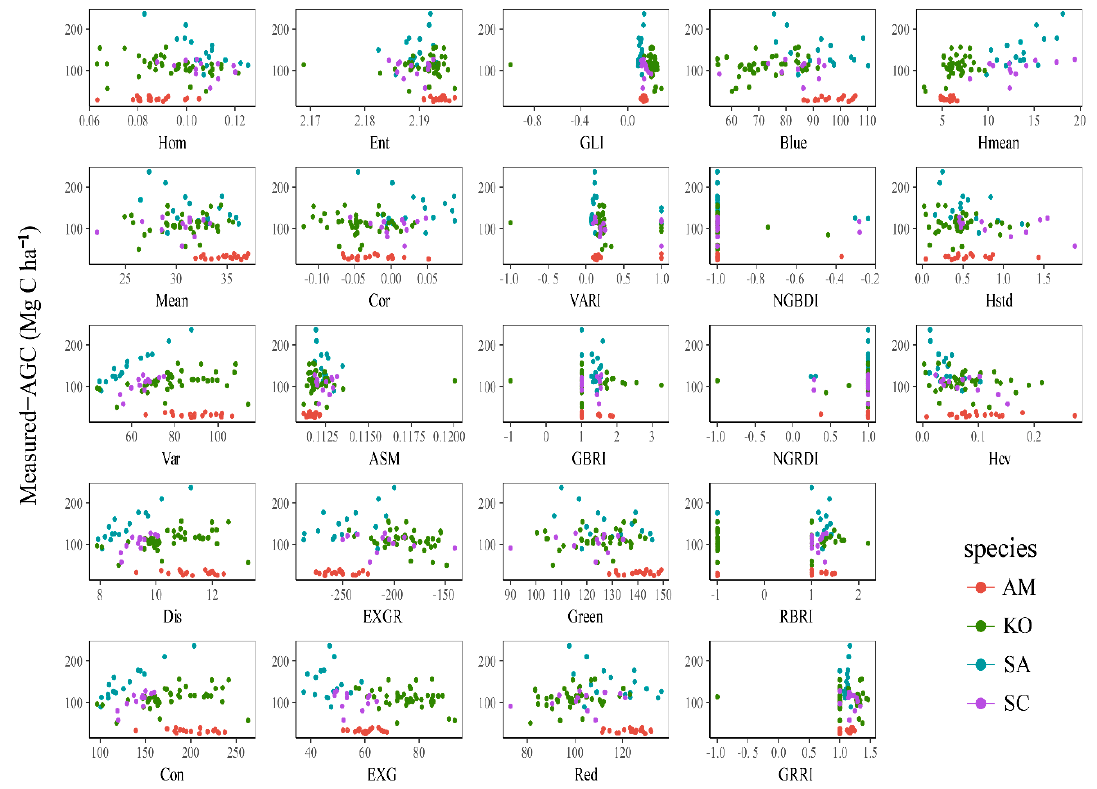
Figure 4. Scatterplots between the variables (texture features (19 × 19), vegetation indices and height metrics in Table 3) and the measured aboveground carbon stock (AGC) values of various species.